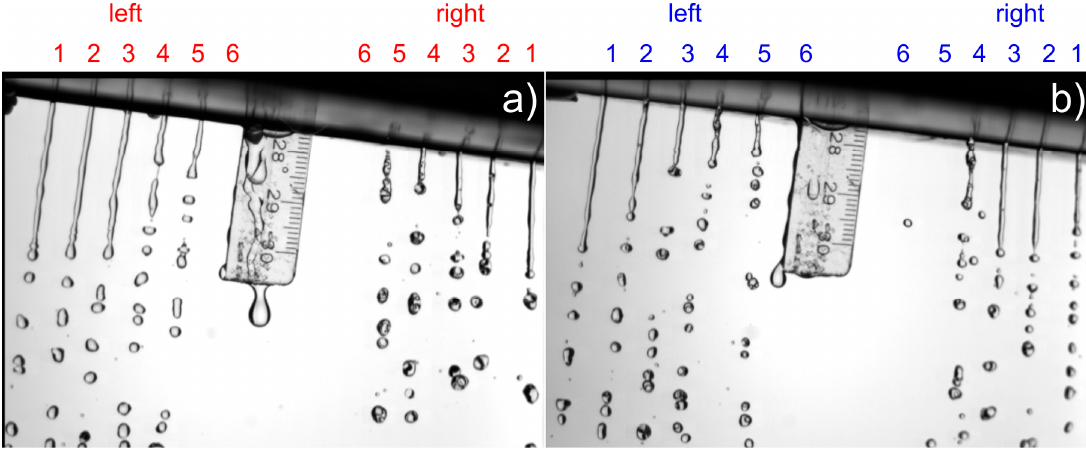
Figure 4. Individual jet comparison of the spray of regular ( a ) and vortex ( b ) showerhead at 8 L h -1 flow rate, 22.7 °C temperature using a tray filter, allowing only one line of nozzles to produce an undisturbed jet path to be imaged.